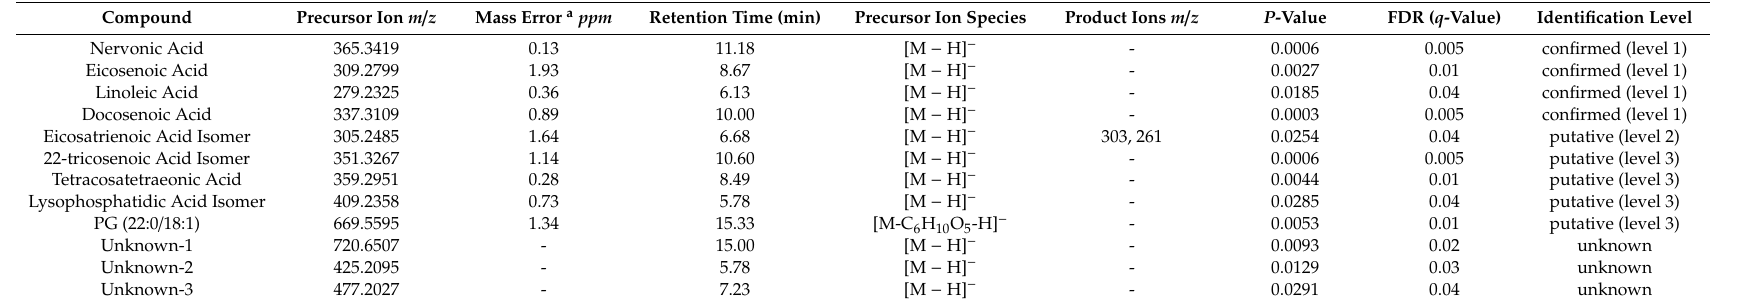
Table 1. List of metabolites significantly impacted by chemotherapy treatment.